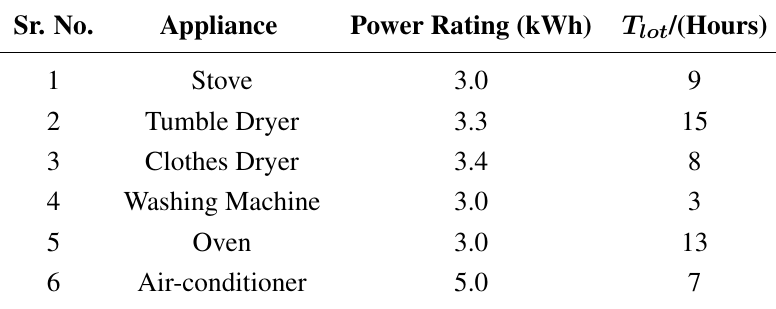
Table 1. Appliance